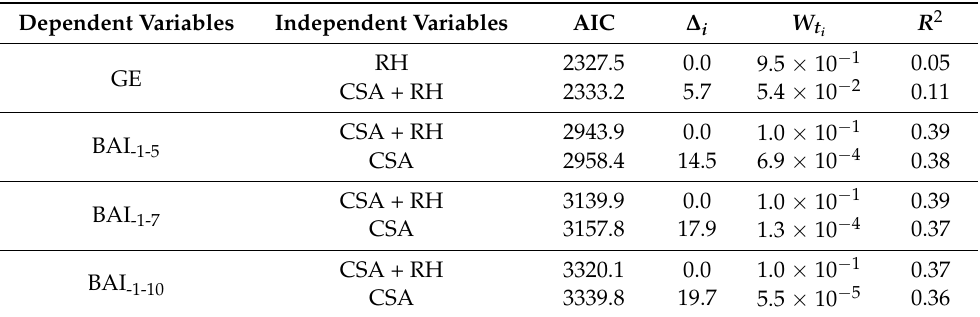
Table 5. Statistics of linear mixed models relating the growth efficiency index (GE) and three growth-based indices to state variables at tree and stand levels. All models also included an intercept, tree species (fixed effect), and a random site